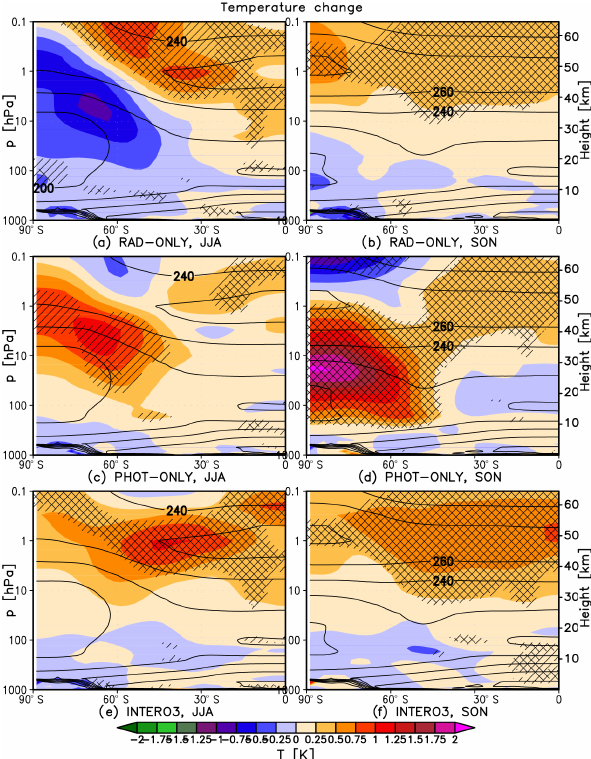
Figure 4. As in Fig. 3 but for the SMAX–SMIN zonal mean tem- perature changes (K) (shading) and climatological zonal mean tem- perature in SMIN run (contours). Contours spacing is 20K (shown for values beginning at 140K).